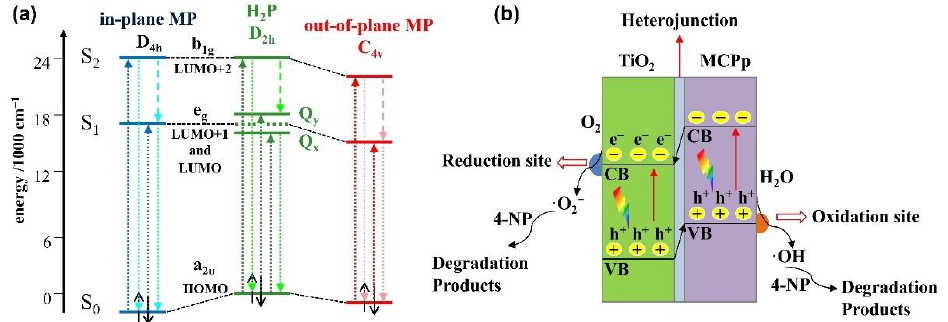
Figure 3. ( a ) Simplified energy level diagram for the change of porphyrin molecular orbitals in different types of complexes. Adapted from reference [51] with permission from Elsevier, copyright 2013; ( b ) photocatalytic mechanism of metalloporphyrin–TiO 2 hybrid under halogen lamp irradiation. Adapted from reference [52] with permission from Elsevier, copyright 2017.